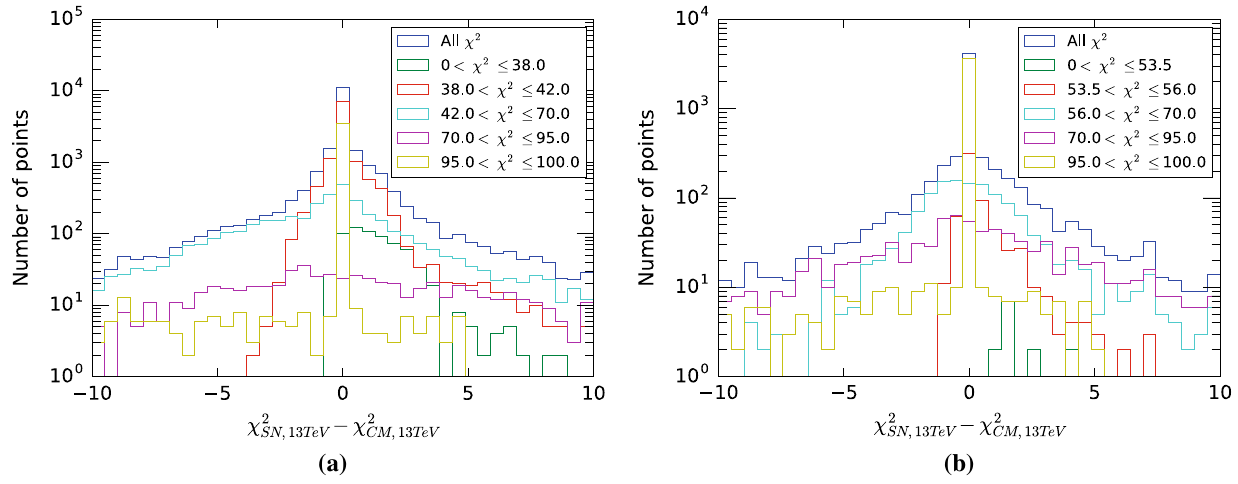
Fig. 14 Performance of the neural network trained on the reparametrized pMSSM-11 points at 8 TeV ( a ) and 13 TeV ( b )